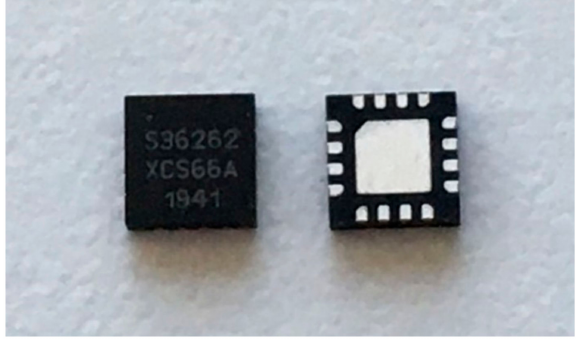
Figure 11. Mercury2 in QFN16 3 × 3